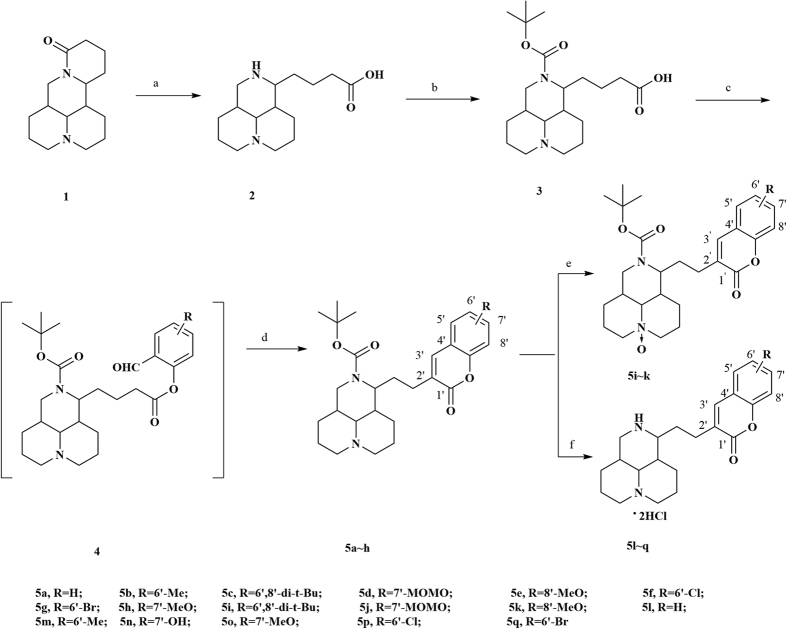
General synthetic route for target compounds.Reagents and conditions: (a) 20% aqueous KOH, reflux, 16 h; then 20% H2SO4; (b) (Boc)2O, Et3N, methanol, reflux, 3 h; (c) pivaloyl chloride, Et3N, DMAP, CH2Cl2, rt, overnight; (d) DBU, toluene, reflux, 32 h; (e) m-CPBA, CHCl3, 0 °C, 3 h; (f) HCl gas, PE/EtOAc (1:1 v-v), rt, 1 h.